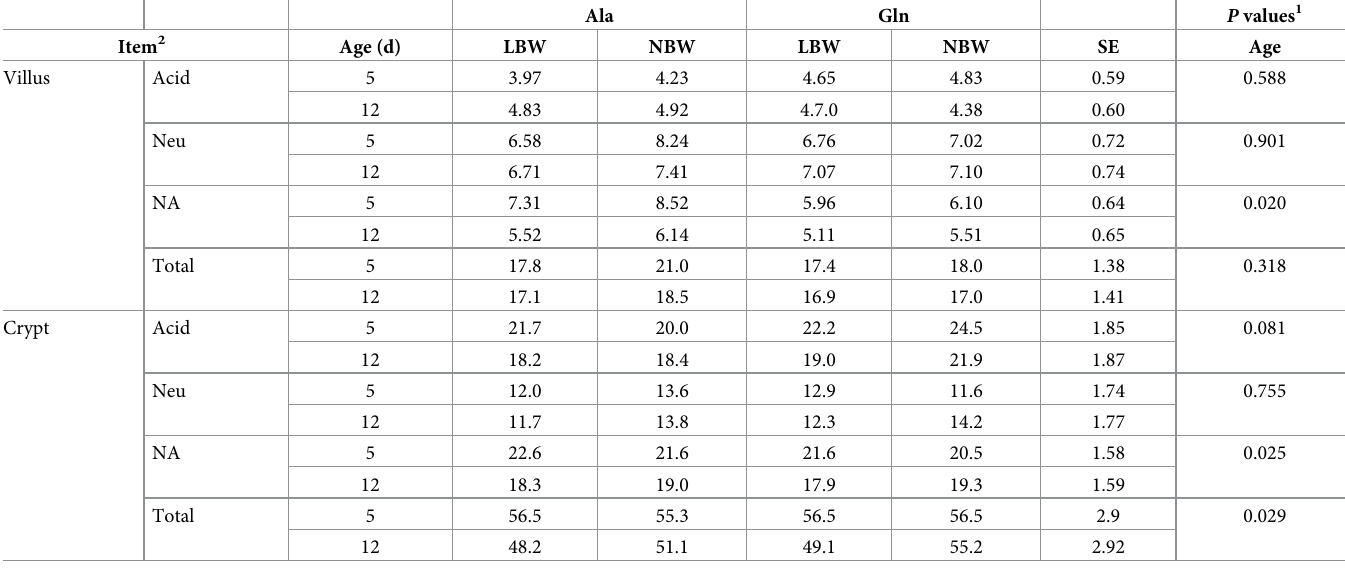
(Table 1). Mixed mucins containing goblet cells in villi were affected by Suppl ( P = 0.007) (Table 2). Age affected the number of mixed mucins containing goblet cells in crypts ( P = 0.025) and villi ( P = 0.020), as well as the total number of goblet cells in the crypt Table 2. Number of jejunal goblet cells in low and normal birth weight male suckling